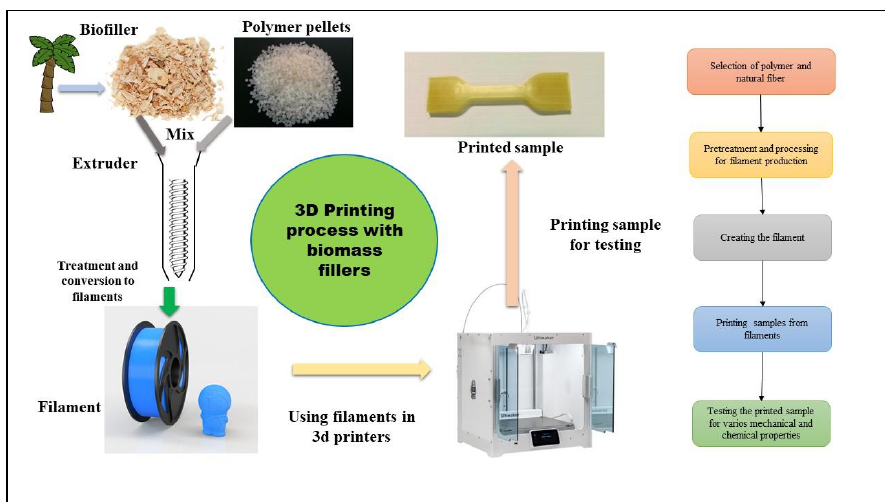
Figure 1. Different polymers used in reviewed studies.